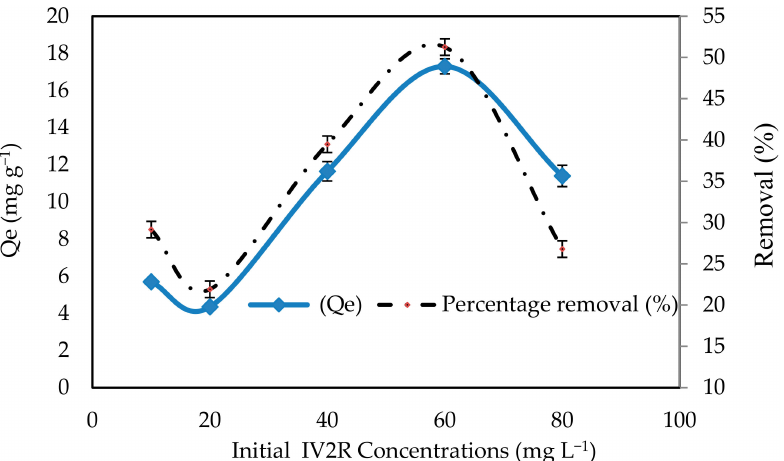
Figure 5. The removal efficiency for P. capillacea nanoparticles with several IV2R